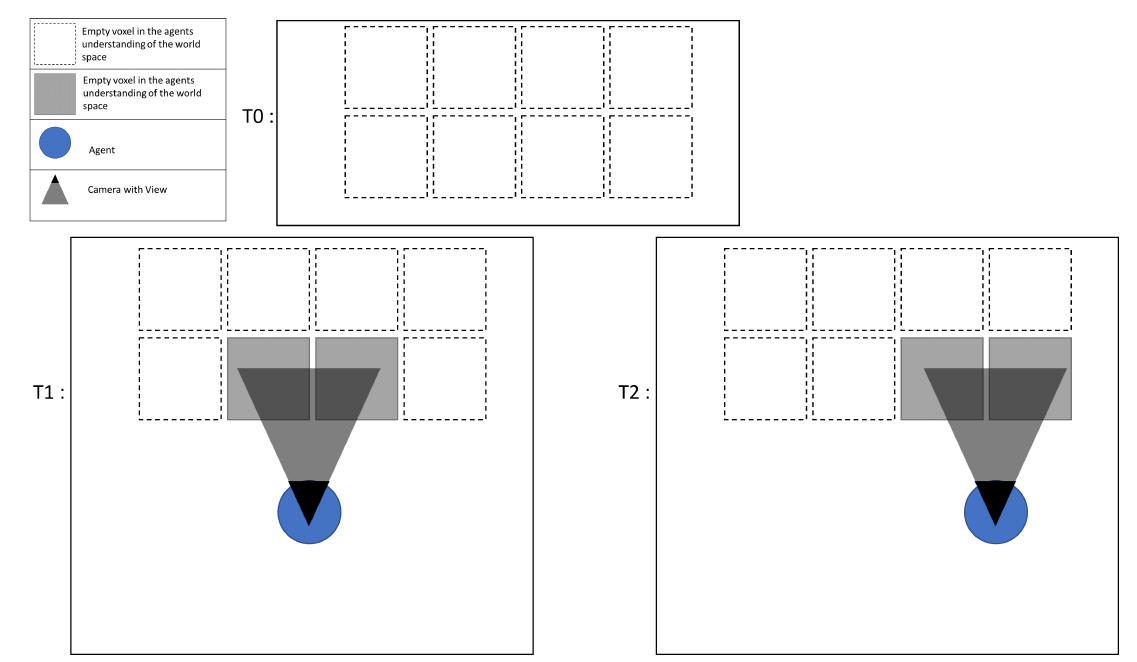
Figure 3. Figure illustrating an agent initializing two different sets of voxels based on the position of the environment.